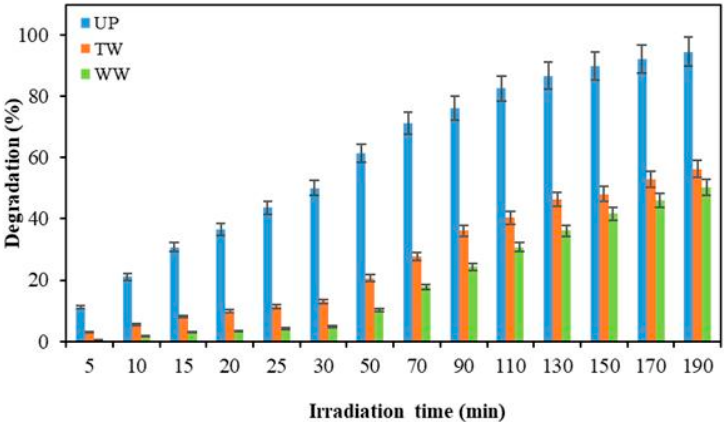
Figure 7. Effect of the water matrix on the photocatalytic degradation of clofibric acid (30 mg/L of clofibric acid, 1 g/L of catalyst, 9.52 mW/cm 2 , room temperature).